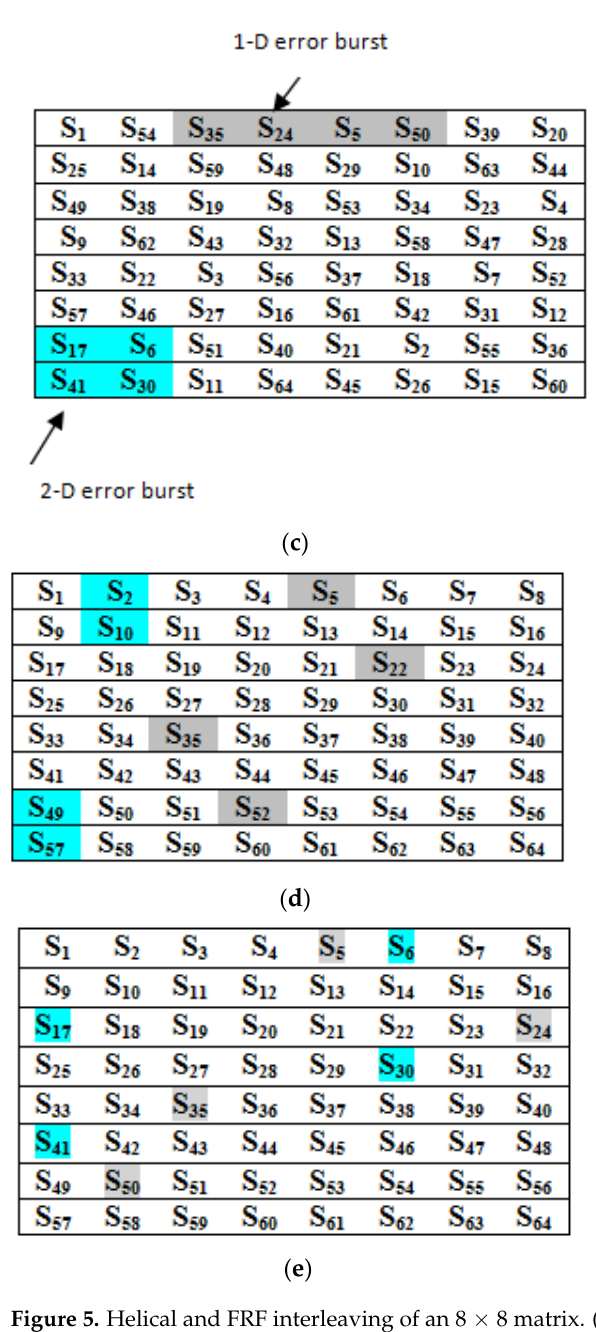
Figure 6. Block diagram of the proposed (FFT/DWT)-OFDM system model. 5. Simulation Results The experiments in this section have been carried out using the MATLAB 7.5 pro- gram. Experiments have been conducted on an i5-2.3 GHz laptop running Microsoft Win- dows 7. In this section, computer simulations are presented to examine and evaluate the BER performances of different scenarios. 1.